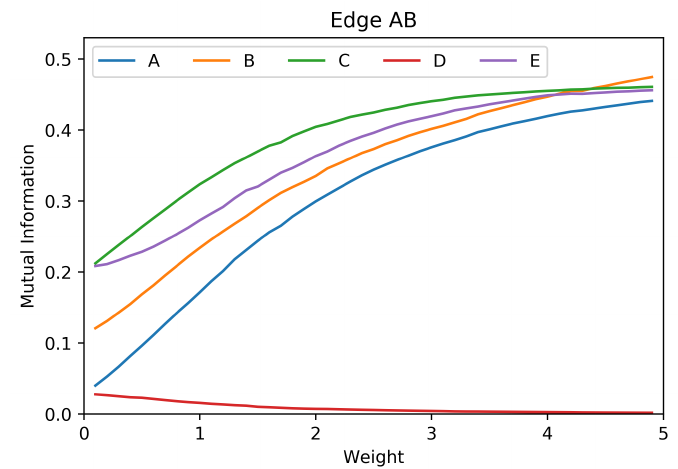
Figure 6. Mutual information between node Z and each other node, varying the edge A-B